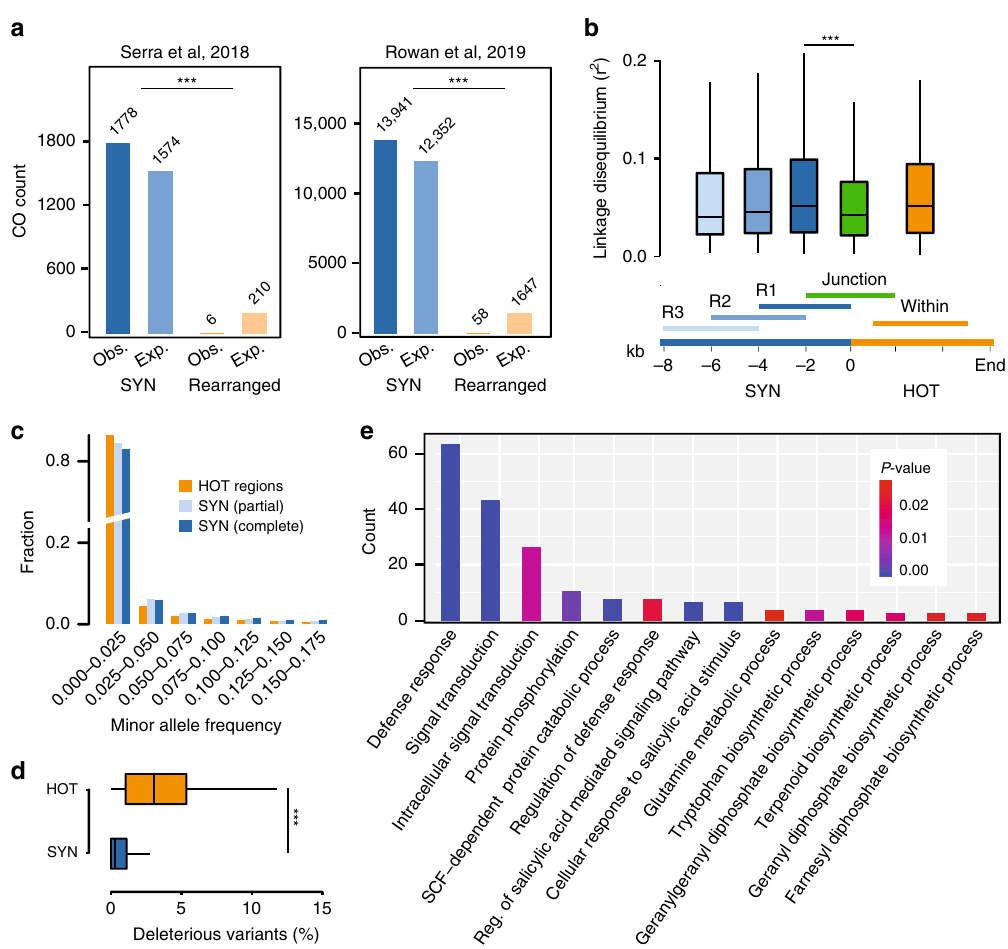
Fig. 5 The causes and consequences of hotspots of rearrangements. a Crossover (CO) breakpoints 35,36 identi fi ed in Col-0 x L er hybrids were checked for their overlaps in syntenic or rearranged regions. Only unique CO intervals smaller than 5 kb were used. Obs.: observed. Exp.: expected. One-sided χ 2 test was used. b Linkage disequilibrium (LD) calculated in 4 kb windows in and around each of the 576 HOT regions as shown in the lower part. SYN, syntenic region. LD was calculated as the correlation coef fi cient (r 2 ) based on informative SNP markers (MAF > 0.05, missing rate < 0.2) selected from the 1001 Genomes Project data 8 . One-sided U test was used. c Minor allele frequency of SNP markers in 10,331 syntenic, 10,501 partially syntenic, and 576 HOT regions. The SNP markers (MAF >0.005, missing rate< 0.2) from 1001 Genomes Project were used. d Frequency of deleterious mutations in 10,331 syntenic (SYN) regions and 576 HOT regions. Deleterious mutations include SNPs and small indels that introduce premature stop codons, loss of start or stop codons, frameshifts, splicing sites mutations or deletions of exons. One-sided U test was used. e GO term enrichment analysis of protein-coding genes in 576 HOT regions. Fisher exact test used, p < 0.05. In box plots b and d , centre line: median, bounds of box: 25th and 75th percentiles, whiskers: 1.5 * IQR (IQR: the interquartile range between the 25th and the 75th percentile). p < 0.001: ***. Source Data are provided as a Source Data fi